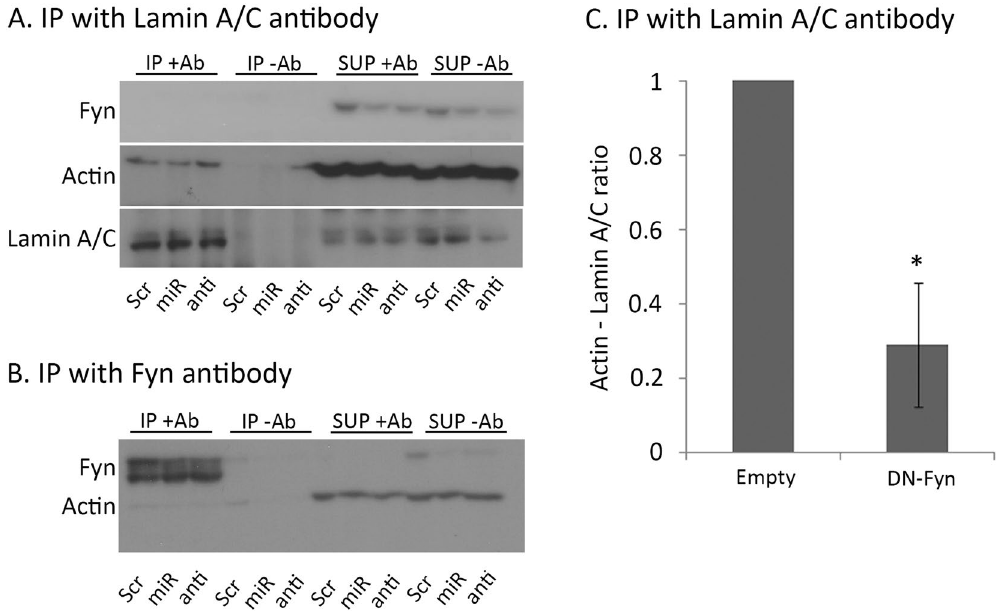
Figure 7. Fyn does not generate a complex with either A-type lamins or actin, but its activity is required for stabilization of the interaction of A-type lamins and actin. ( A , B ) HEK-293 T cells were transfected with either miR-125a-3p mimic (miR), anti-miR (anti) or scramble-miR (Scr), incubated for 24 hours, lysed and immunoprecipitated (IP + Ab) with ( A ) anti-lamin A/C antibody. The immunoprecipitated complexes were immunoblotted with anti-Fyn, anti-actin and anti-lamin A/C antibodies or immunoprecipitated with ( B ) anti-Fyn antibody and then immunoblotted with anti-actin and anti-Fyn antibodies. A negative control with no added antibody (IP-Ab) is displayed for each treatment. The supernatant that remained after immunoprecipitation is also displayed (SUP + Ab, SUP-Ab). ( C ) HEK-293 T cells were transfected with an empty-vector (Empty) or a vector encoding for dominant-negative form of Fyn (DN-Fyn), incubated for 24 hours, lysed and immunoprecipitated with anti-lamin A/C antibody and then immunoblotted with anti- actin and anti-lamin A/C antibodies. Data were analyzed by one-sample two-tailed student t-test. Bars are Mean ± SEM of three independent experiments, * p <